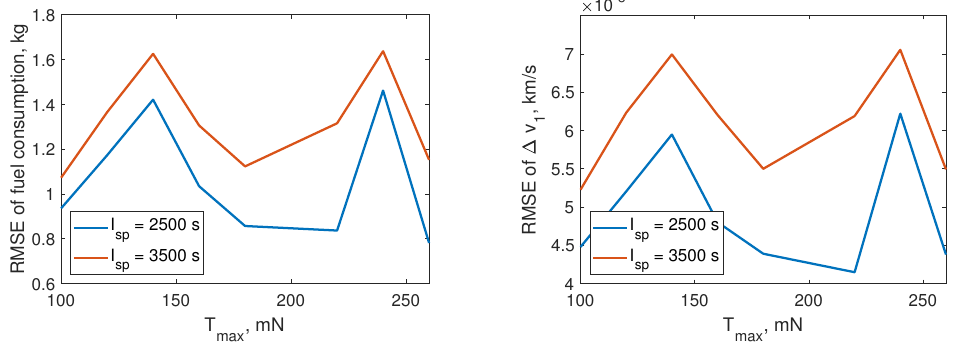
Figure 12. RMSE of the estimation of fuel consumption and magnitude of impulsive burn with the interpolation